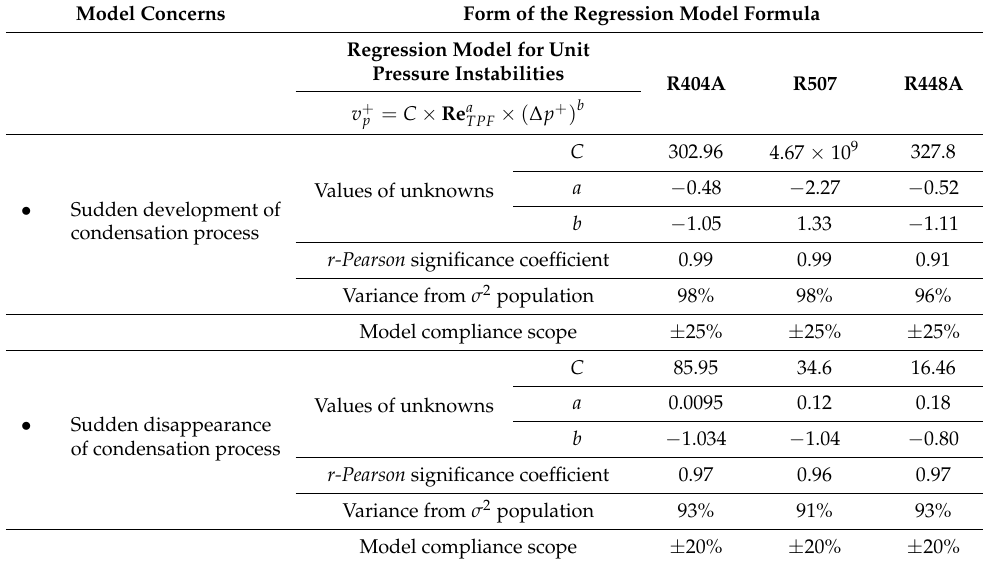
Table 2. Values for the regression model of pressure instabilities. Model